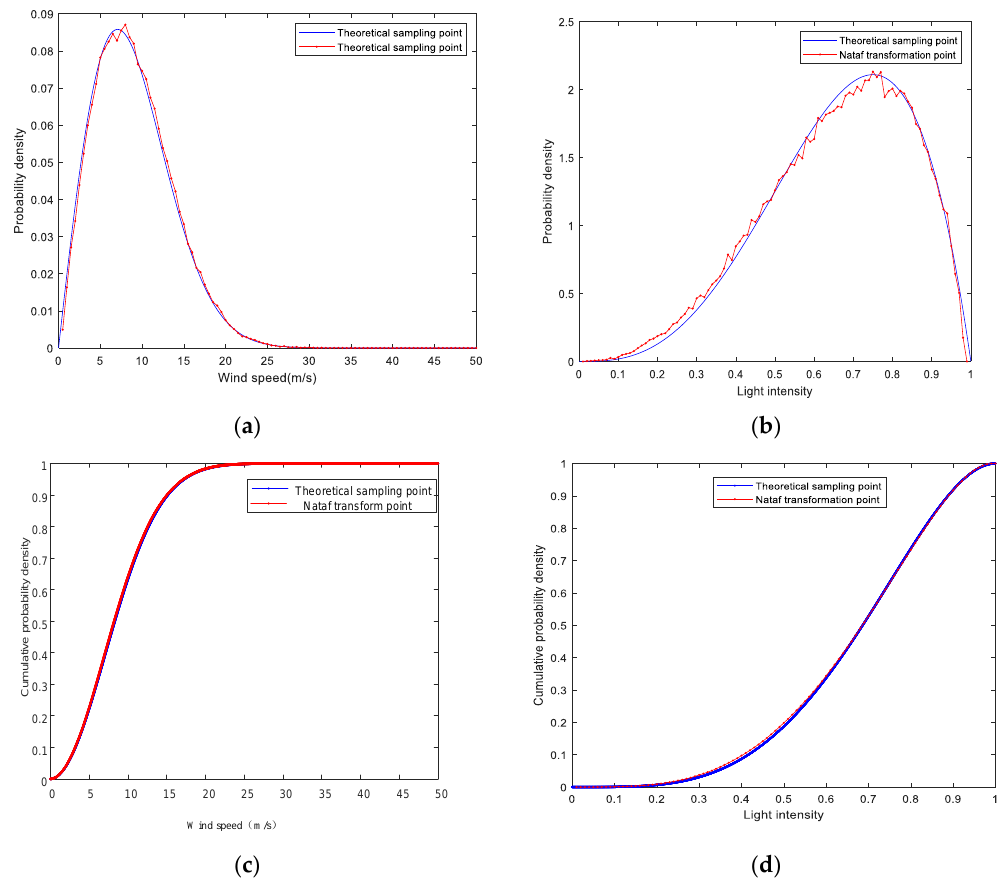
Figure 3. Probability density of sampling points in ( a ) wind power plants and ( b ) photovoltaic power plants. Cumulative probability distribution of ( c ) wind power plants and ( d ) photovoltaic power plants.